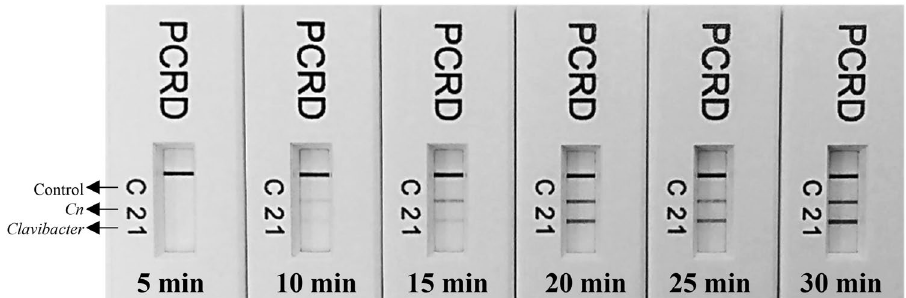
Figure 2. Determination of optimum time for successful detection of the genus Clavibacter and C. nebraskensis using the developed multiplex RPA assay. Line 1: detects Clavibacter species/subspecies strains; line 2 detects C. nebraskensis strains, and; line C is a control line. The primer/probe sets for genus Clavibacter and C. nebraskensis are labeled with Biotin/DIG and Biotin/FAM, respectively. The detection can be achieved within 10 min but the optimum line intensity on PCRD was observed in 20–30 min.